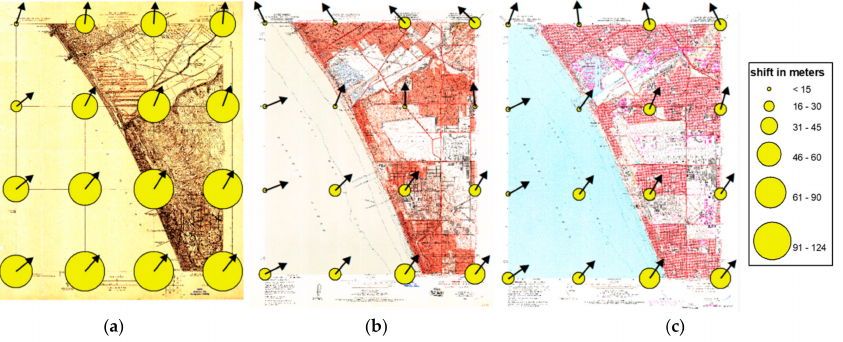
Figure 10. Displacement vectors at GCP locations characterizing the distortions introduced during the georeferencing of USGS topographic maps (scale 1:24,000) from Venice (California), produced in ( a ) 1923, ( b ) in 1957, and ( c ) in 1975 (from left to right).